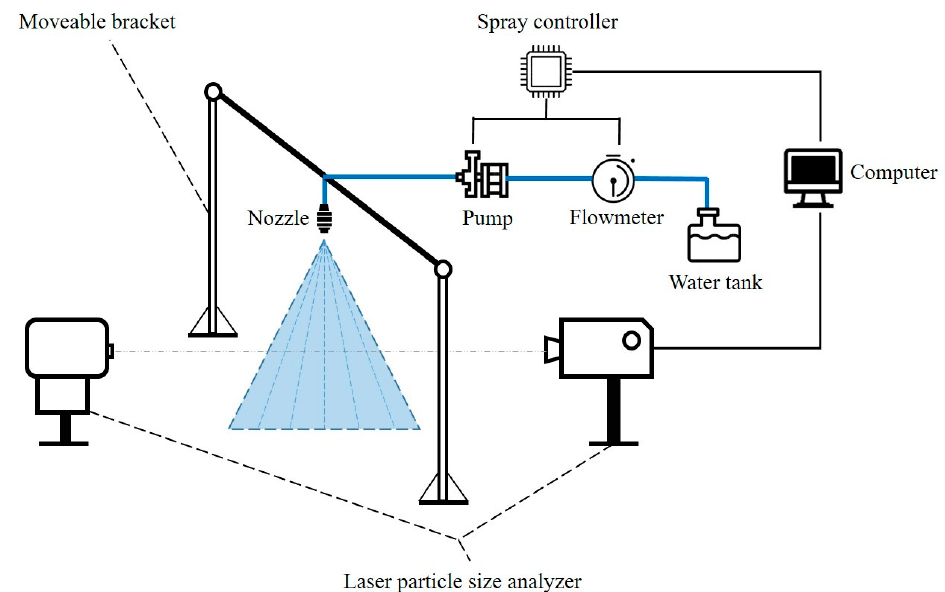
Figure 1. Arrangement of experimental instrument.